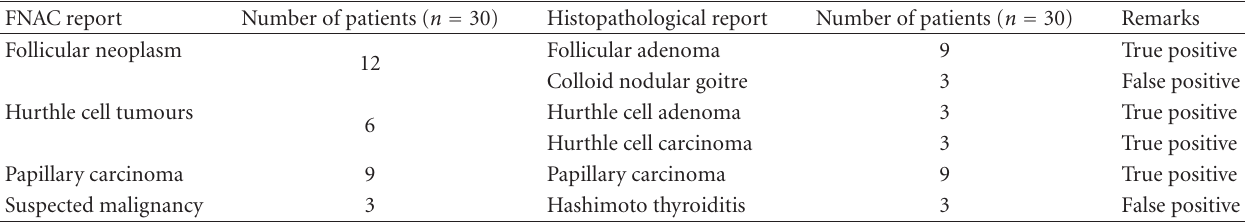
Table 3: Benign or suspicious neoplastic lesions diagnosed by FNAC and their comparison with histopathological diagnosis.